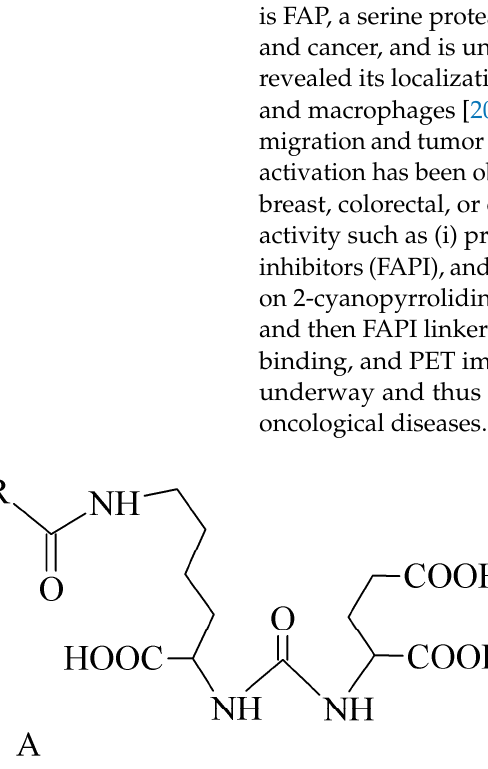
Figure 18. Structural motifs of small peptide inhibitors of proteins. ( A ) EuK motif as a base for PSMA inhibitors, ( B ) 2-cyanopyrrolidin-quinoline carboxamides as a base for FAP inhibitors. Table 13. Summary of radiolabeled small peptide inhibitors for PSMA- and FAP-positive tumor imaging over past 3 years.